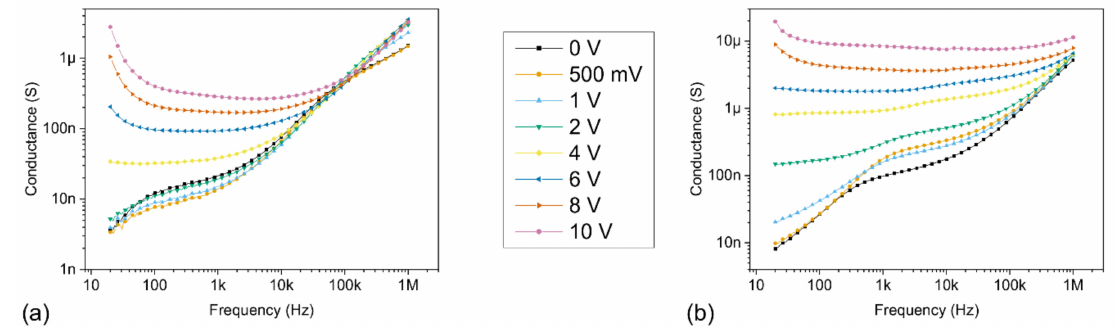
Figure 12. (G-f) characteristics under dark and light conditions for different fixed bias voltages ranging between 0 V and 10 V. The frequency was varied with a logarithmic sweep between 20 Hz and 1 MHz; ( a ) log scale under dark conditions; ( b ) log scale under light